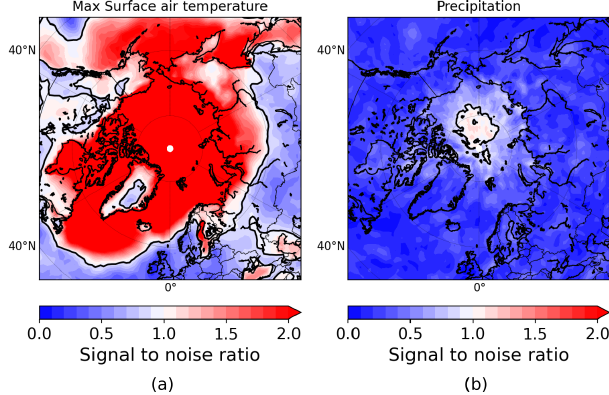
Figure 7. Signal-to-noise ratio in summer averaged for all the mod- els for the daily maximum surface air temperature (a) and for the daily precipitation (b) responses to summer Arctic sea ice loss. The black line represents where the signal-to-noise ratio is equal to